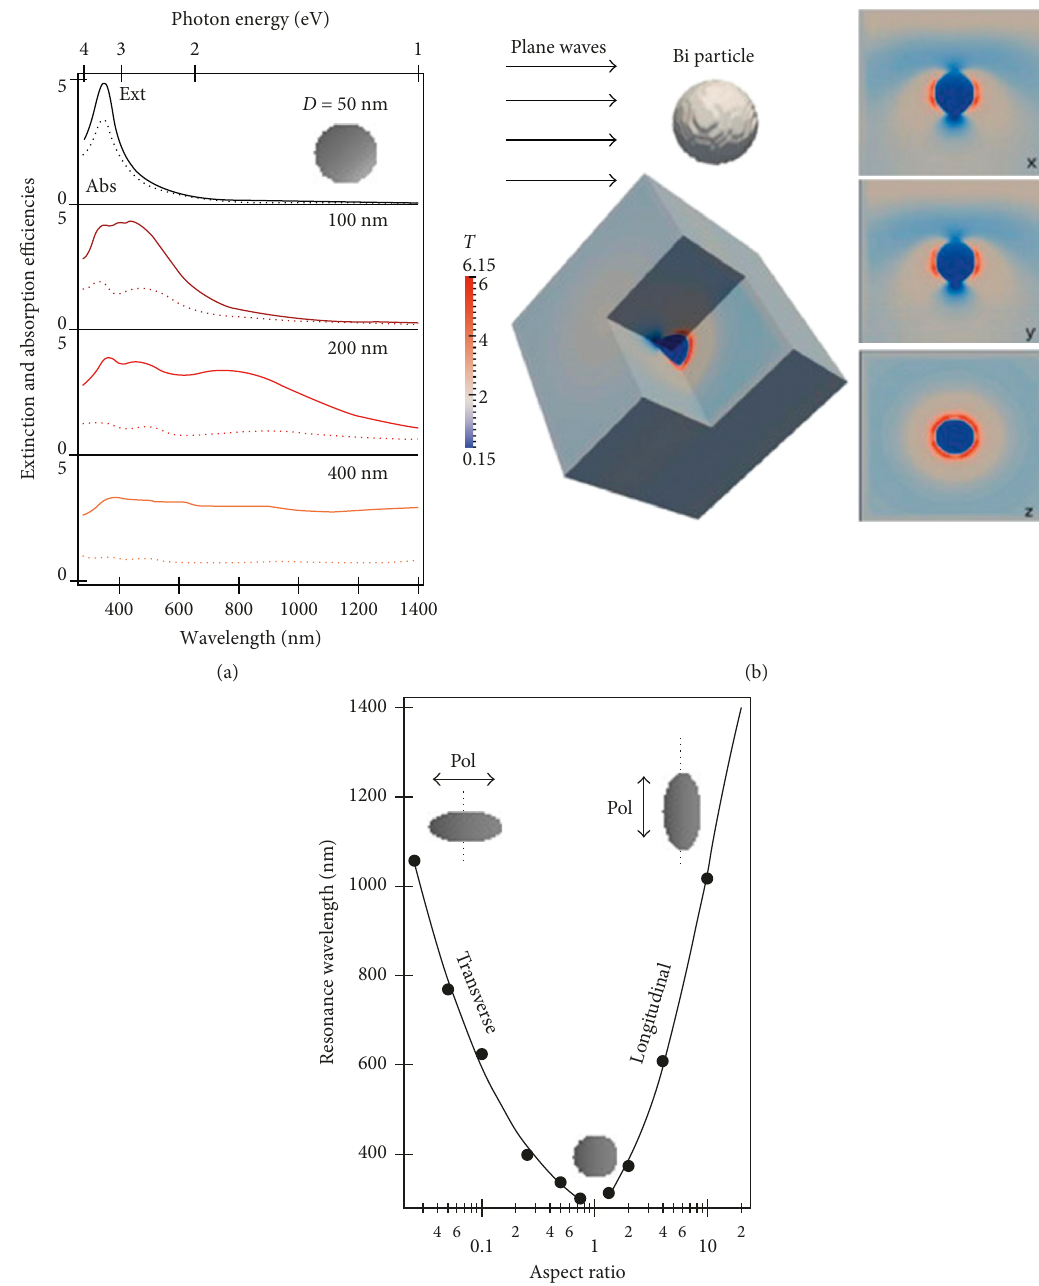
Figure 10: (a) Simulated extinction and absorption efficiency spectra of spherical Bi nanospheres of different diameter D , in water. Simulations have been done using the Mie theory and the dielectric function of Bi given in Figure 1. (b) Simulated near-field intensity (reprinted with permission from [105] © 2015, American Chemical Society). (c) Simulated resonant wavelengths of Bi nanospheroids in water, as a function of their aspect ratio. Simulations have been done using the Gans theory and the dielectric function of Bi given in Figure 1. For an aspect ratio < 1 ( > 1), the transverse (longitudinal) resonance occurs in the UV-to-near-IR